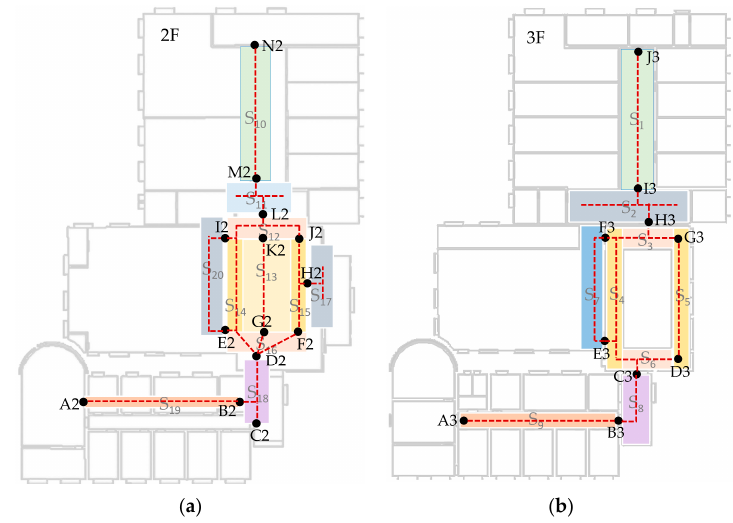
Figure 14. Paths to collect data for localization. ( a ) A2–N2 are TPs on the second floor and ( b ) A3–J3 are TPs on the third floor. In test phase, every path segments between two transition points were repeated at least three times.